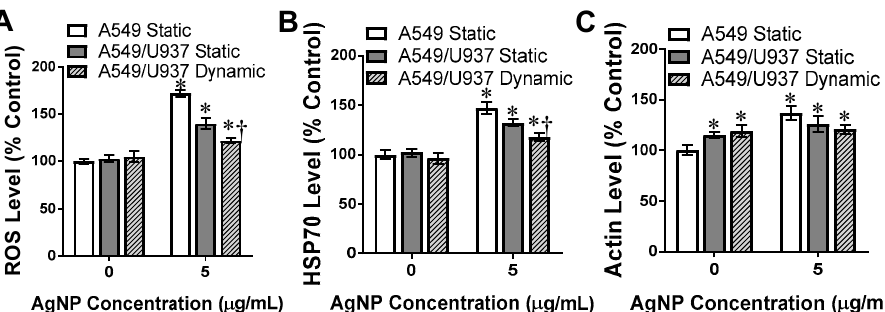
Figure 5. Activation of intracellular stress markers by AgNPs. The denoted experimental in vitro systems were incubated in either fresh media or a 5 µg/mL AgNP solution for 24 h, followed by evaluation of the stress markers ( A ) ROS, ( B ), HSP70, and ( C ) Actin inflammation. * and † denote statistical significance from static, untreated A549 cells and between A549/U937 static and dynamic at the same AgNP concentration, respectively, n = 3, p < 0.05.